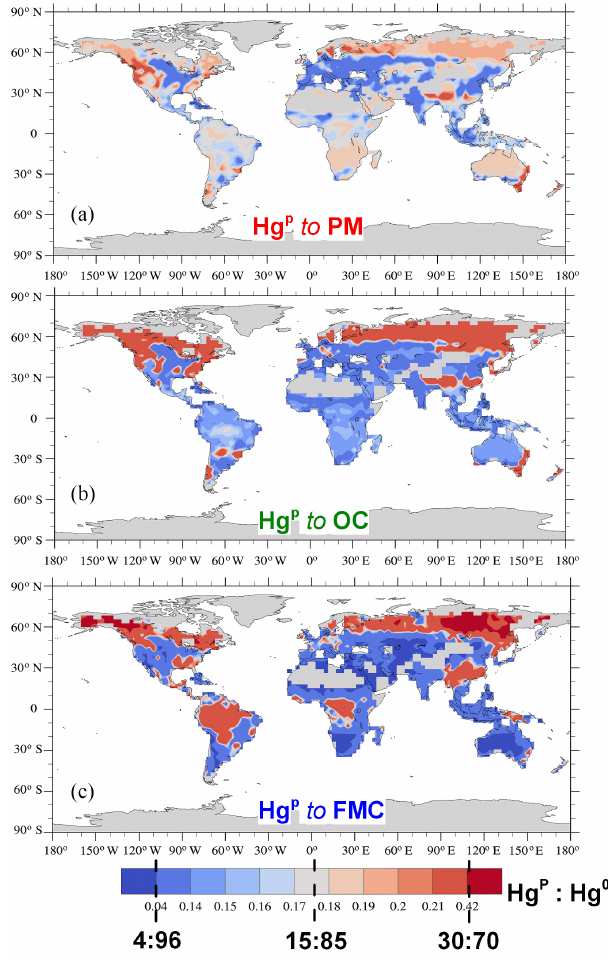
Figure 3. Geographical distribution of the Hg P :Hg 0 ratio, when mapped to PM (a) and OC (b) and when speciation is determined by FMC (c) . In the colour bar the levels corresponding to the constant speciations (4:96, 15:85 and 30:70 Hg P :Hg 0 used for the emissions mapped to CO are indicated.